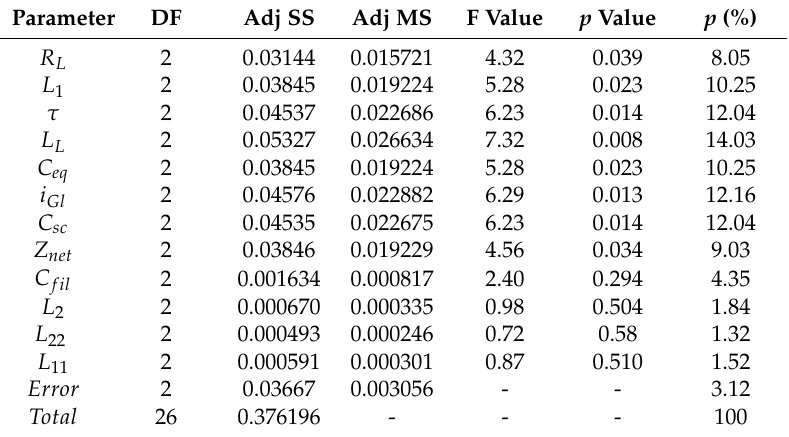
Table 3. Result of analysis of variance of signal to noise